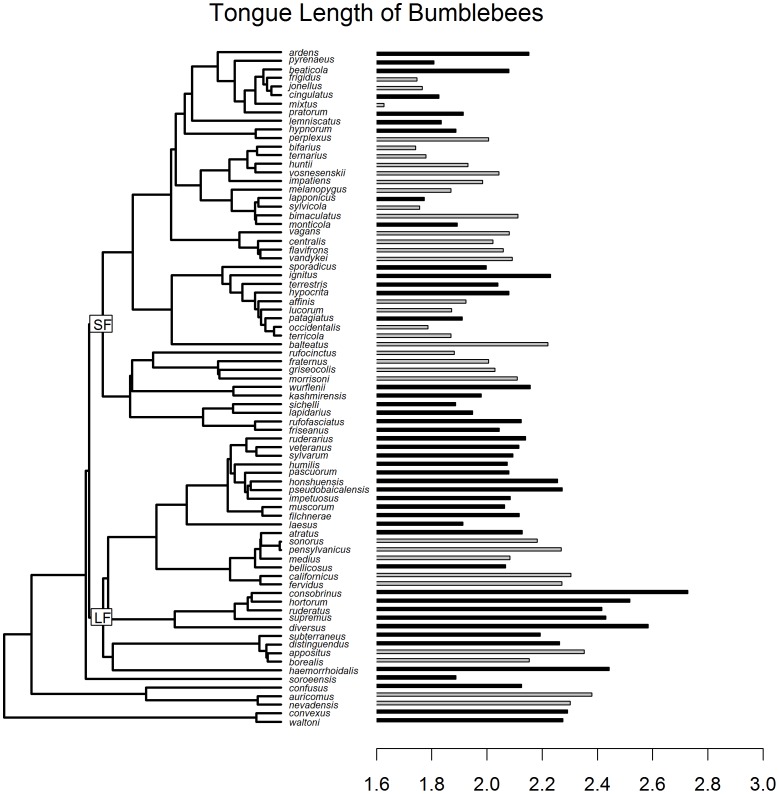
Bi-plot of the phylogeny of species with trait values (n = 79) and the associated tongue length measured in ln(mm).Grey bars indicate species found in the Nearctic. Short faced (SF) and long faced (LF) sister clades are labeled to demonstrate the association with tongue length. Taxa labels are available in the Supplementary Table 1 with trait values.